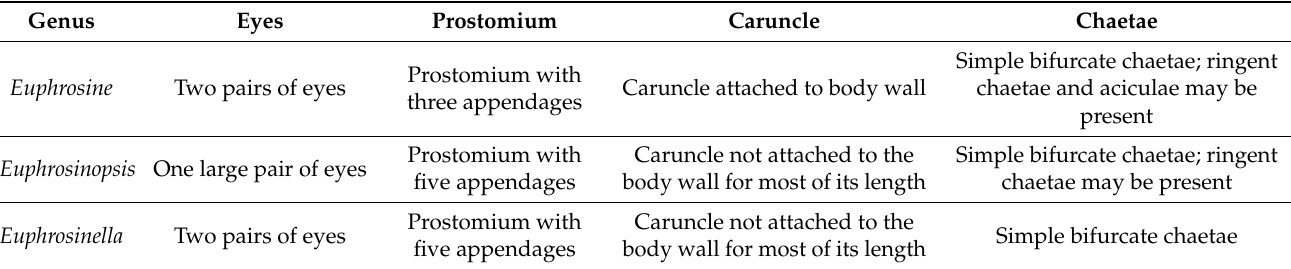
Table 1. Distinguishing features between Euphrosine , Euphrosinopsis , and Euphrosinella . Genus Eyes Prostomium Caruncle Chaetae Simple bifurcate chaetae; ringent Prostomium with Euphrosine Two pairs of eyes Caruncle attached to body wall chaetae and aciculae may be three appendages present Prostomium with Caruncle not attached to the Simple bifurcate chaetae; ringent Euphrosinopsis One large pair of eyes five appendages body wall for most of its length chaetae may be present Prostomium with Caruncle not attached to Euphrosinella Two pairs of eyes five appendages